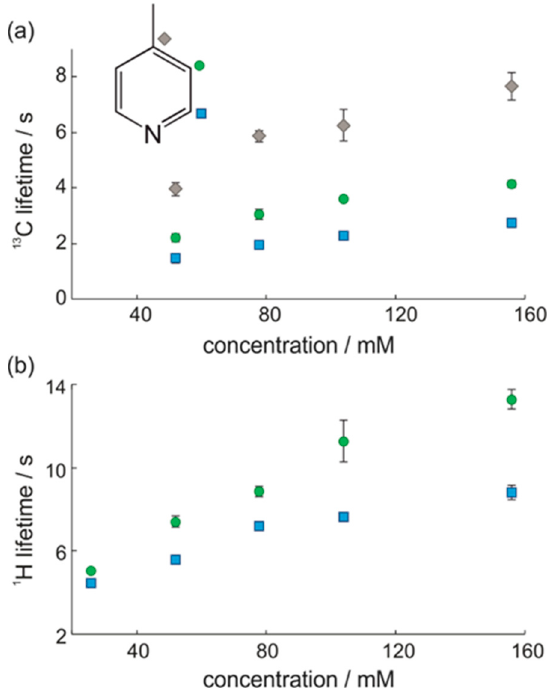
Figure 4. ( a ) 13 C and ( b ) 1 H SABRE-hyperpolarisation lifetimes measured using a single-shot pulse sequence (Figure 2e) at 1 T (43 MHz) for 4-methylpyridine in methanol- d 4 with 5.2 mM SABRE catalyst. Values are the average over five experiments and error bars are the standard error across the repeat measurements.